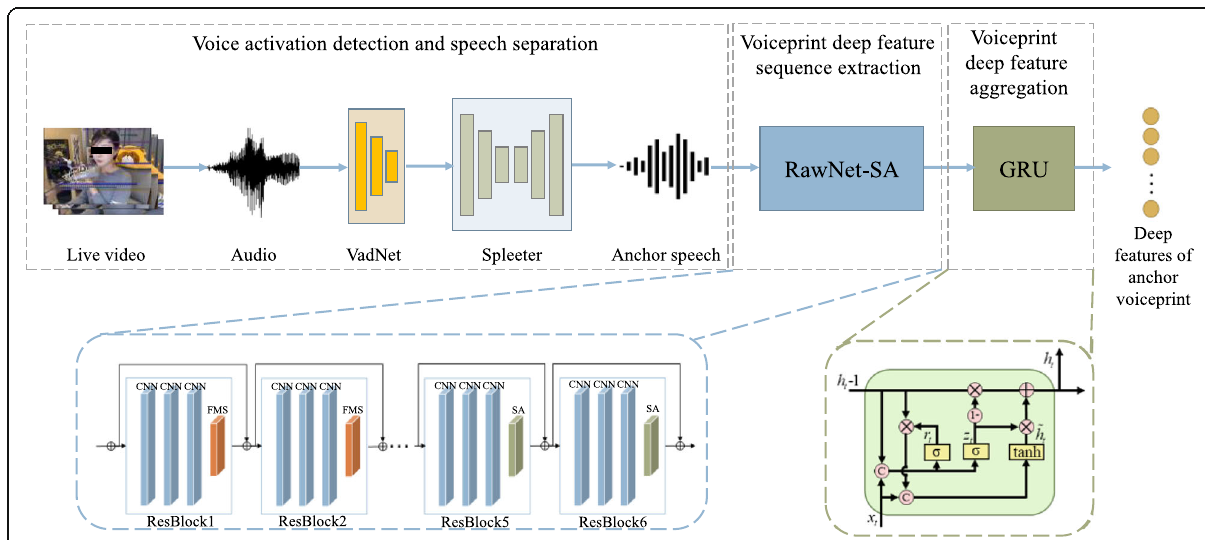
Fig. 3 Framework of the proposed anchor voiceprint recognition method, in which GRU diagram is modified based on